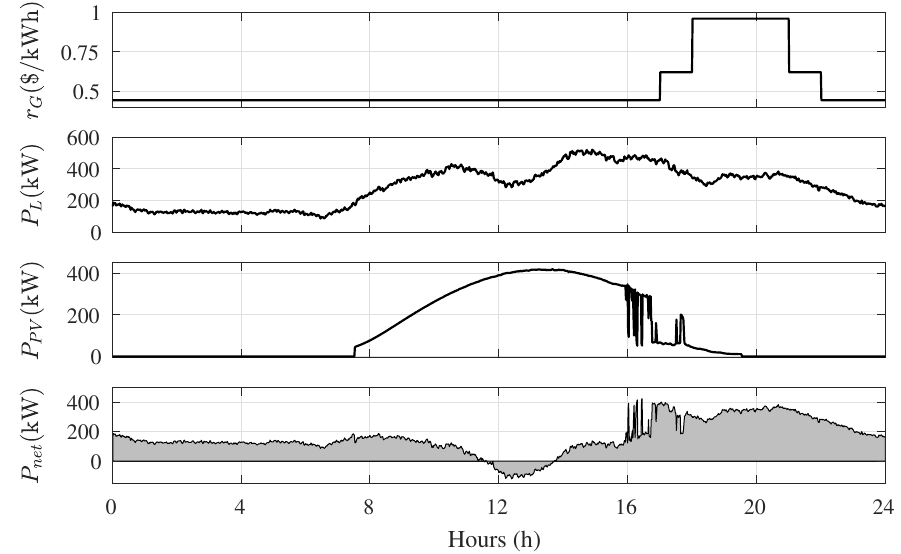
Figure 7. Microgrid profile used in EMS analysis: price of the grid energy ( r G ), load demand ( P L ), PV generation ( P PV ), and the net PCC power ( P net